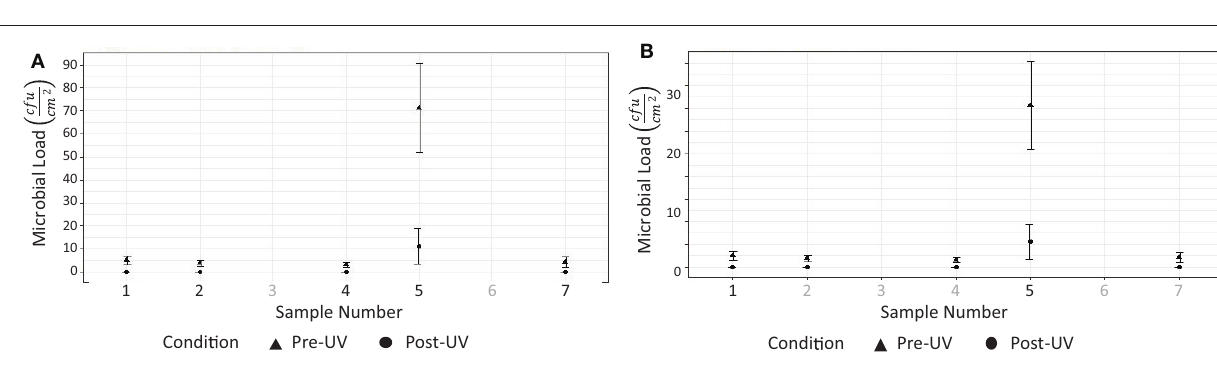
Frontiers in Robotics and AI |